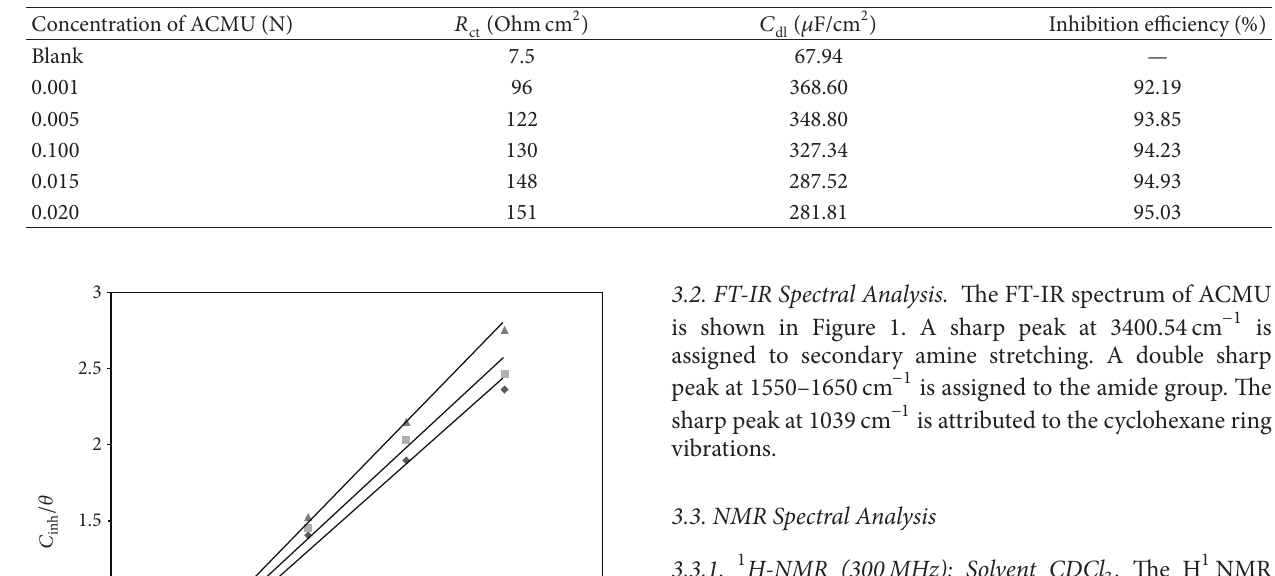
T 6: AC-Impedance parameters for corrosion of mild steel in 1N H